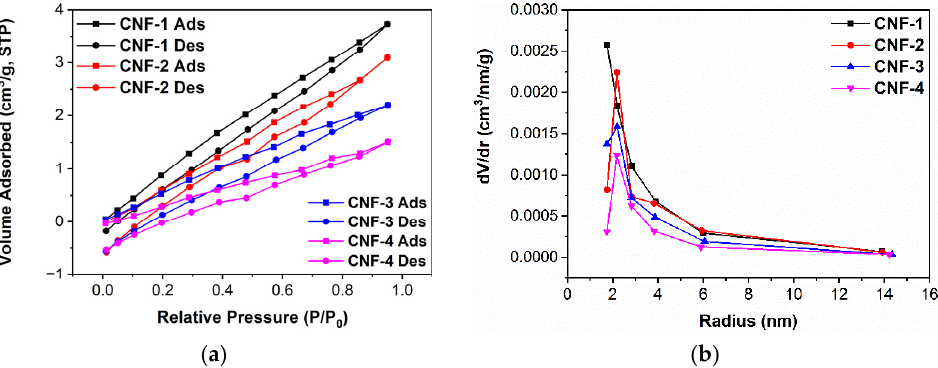
Figure 6. 10 × 10 µm 2 FIB/SEM image of a diagonal corner cross-section of CNF-4.